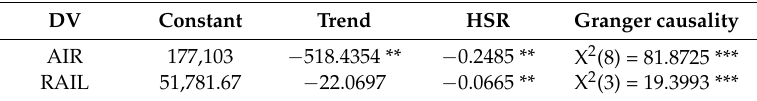
Table 5. Results of CE and Granger causality test.